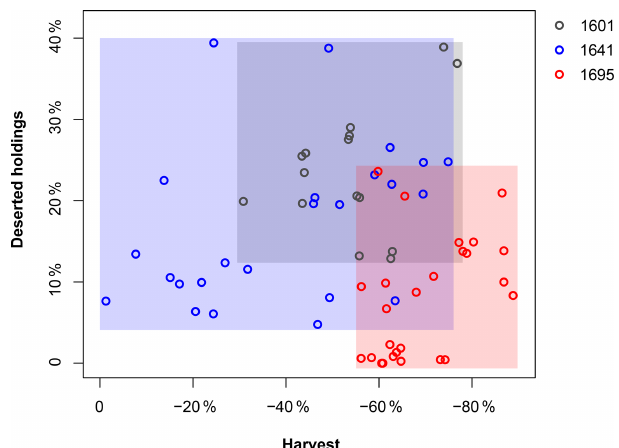
Figure 6. Relationship between 3-year harvest loss and desertion ratio means (data same as in Fig. 5) in Ostrobothnian parishes fol- lowing the three volcanic